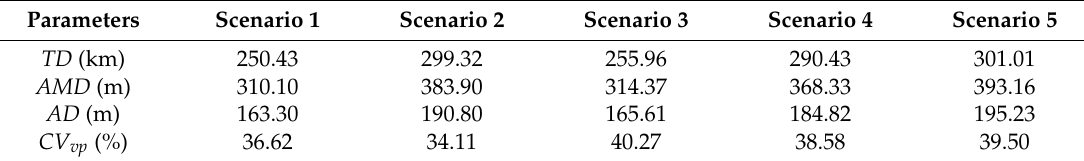
Table 2. Values, in the Euclidean distance, that represent the sum of all the trees harvested in all subareas for each of the scenarios, considering the sum of the distances ( TD ), the average maximum distances ( AMD ), average distance ( AD ), and coefficient of variation of the volume of yard ( CV vp ).